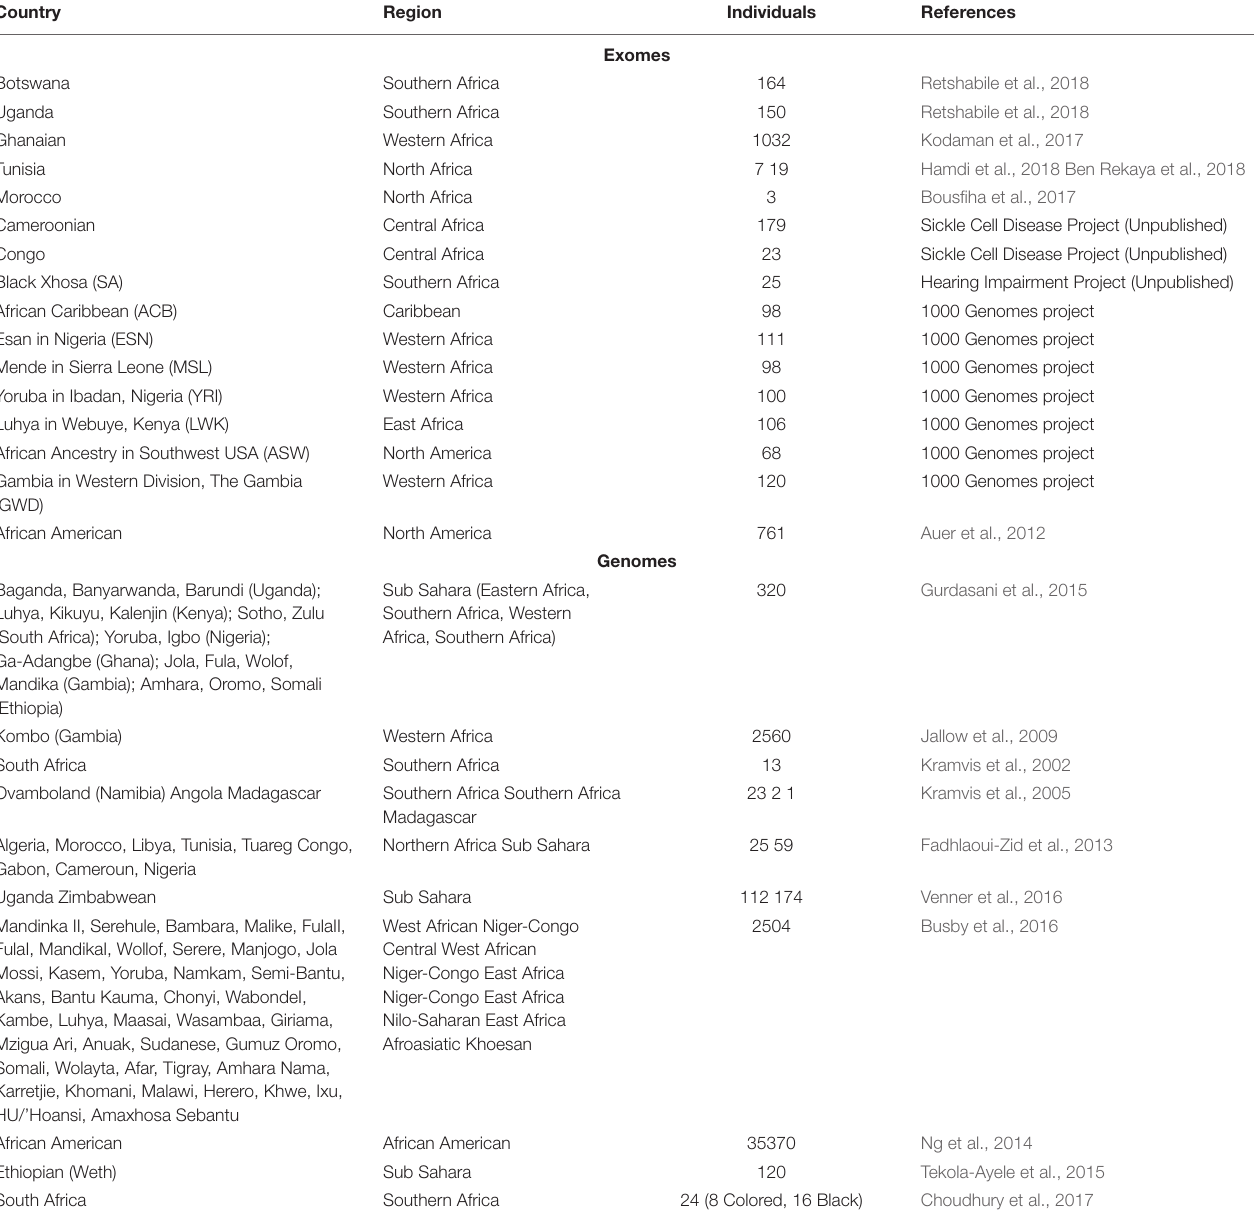
TABLE 1 | Published whole exome and genomes data from sub-Saharan